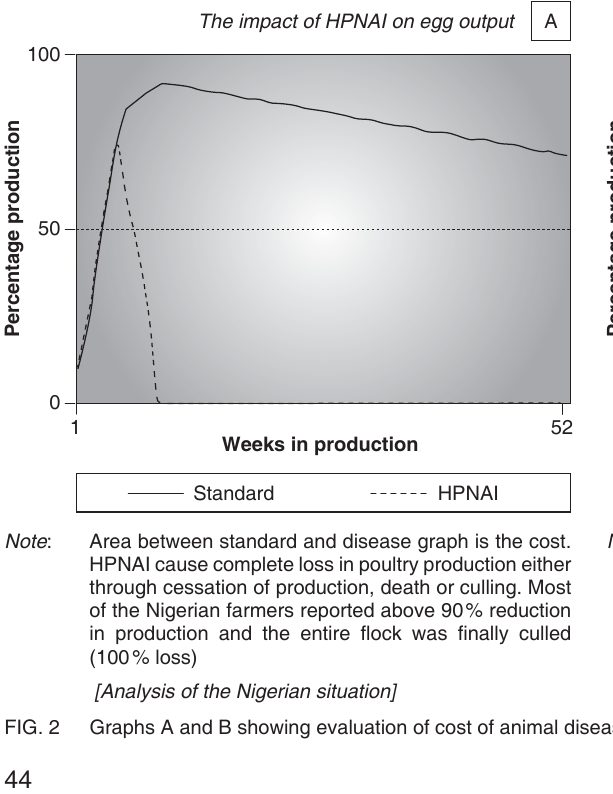
The impact of other diseases on egg